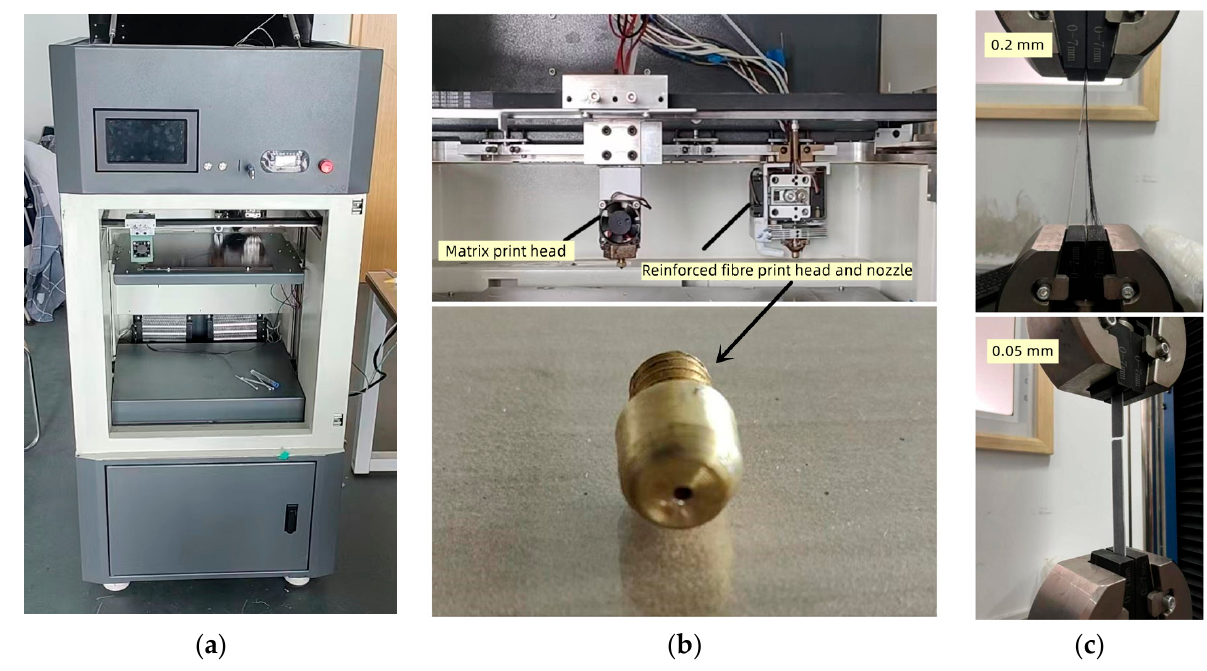
Figure 1. Independent extrusion 3D printer and its specific components: ( a ) Independent extrusion type FFF 3D printer; ( b ) two print heads and the reinforced fiber print nozzle; ( c ) tensile test, failure diagram of specimen with thickness of 0.2 mm and 0.05 mm.